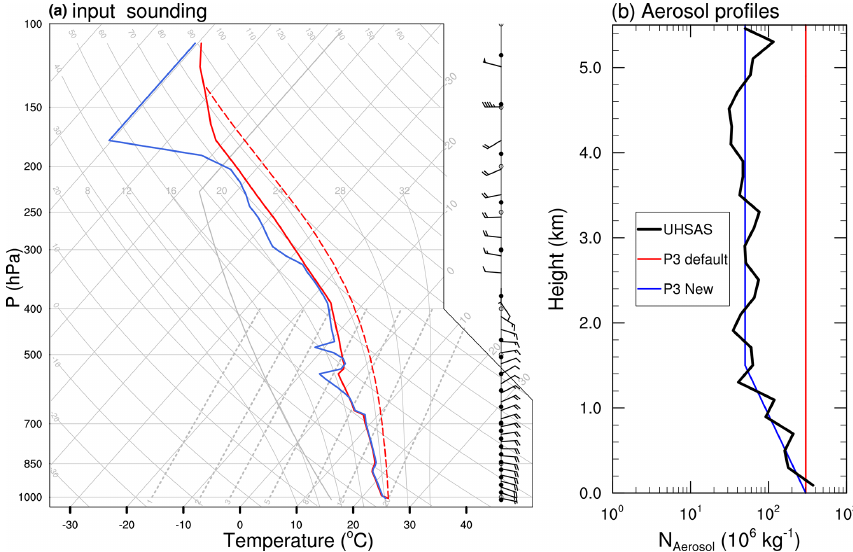
Figure 1. (a) Input sounding from the radiosonde released at Cayenne at 00:00UTC on 26 May 2015. One full wind barb represents 10 knots ( ∼ 5.14ms − 1 ). (b) Profiles of the aerosol number mixing ratio ( N Aerosol in units of 10 6 kg − 1 ; UHSAS observation: black, default profile in P3 scheme: red; new profile based on UHSAS observation: